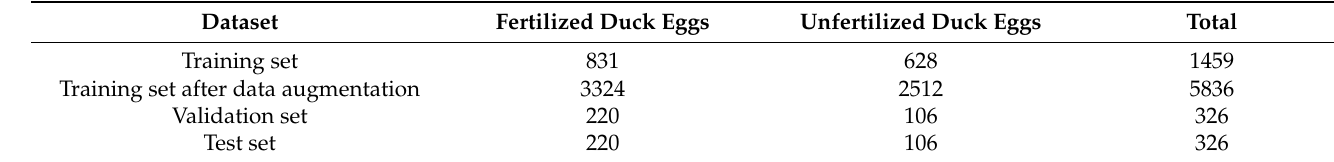
Table 1. The dataset of this